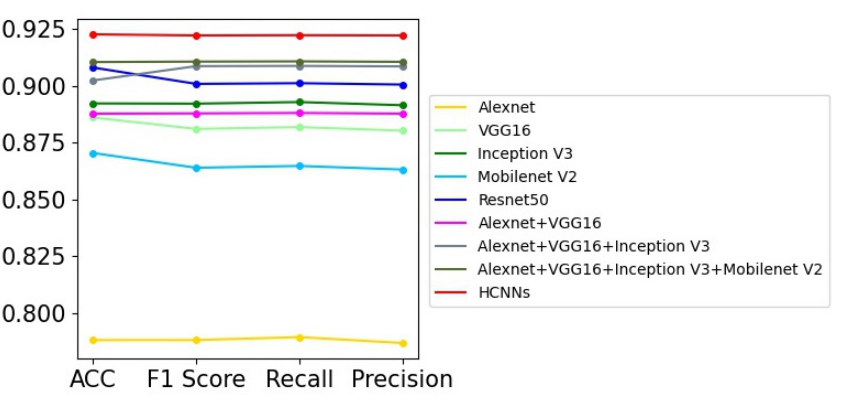
Figure 6. The curve graph of Table 4.